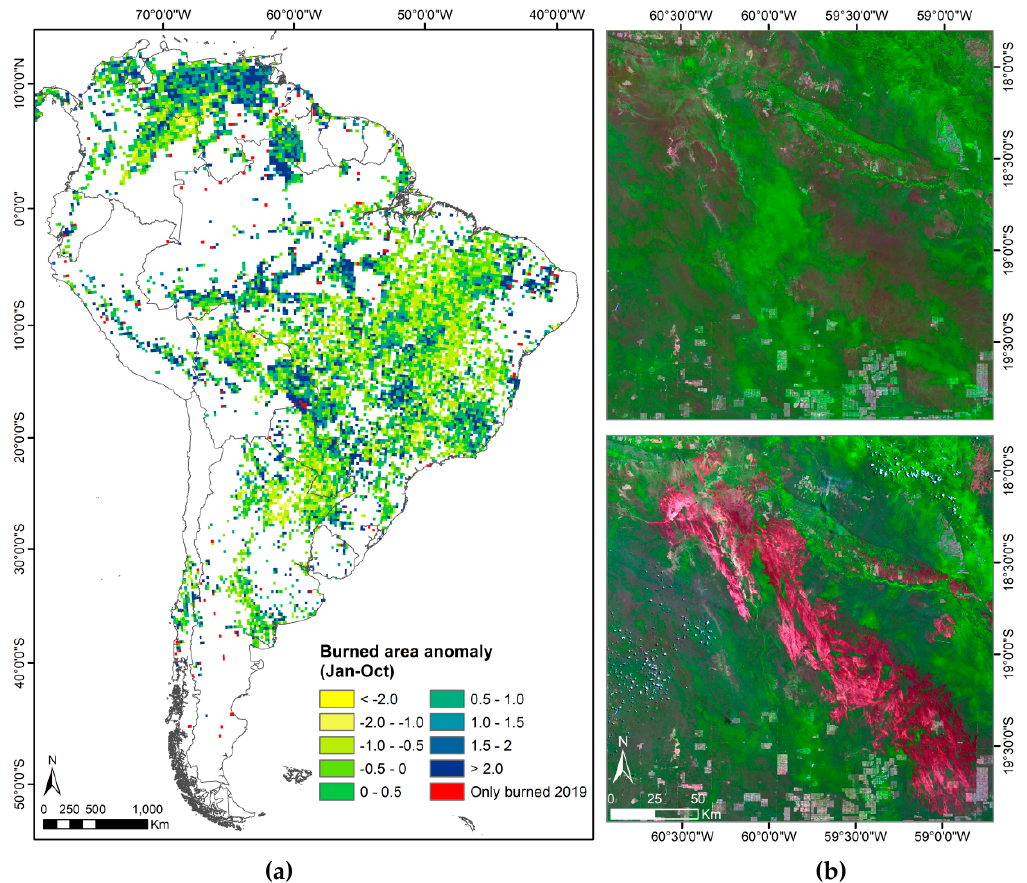
Figure 4. ( a ) Spatial anomalies of 2019 BAs in South America versus the time series of 2001–2018. Anomalies are computed as standardized Z units of BA for grid cells of 0.25 ⁰ degrees. ( b ) Sentinel-2B images of the area burned between the border of northern Paraguay and eastern Bolivia. Top: the pre-fire image of 09 July 2019; bottom: the post-fire image of 17 October 2019.